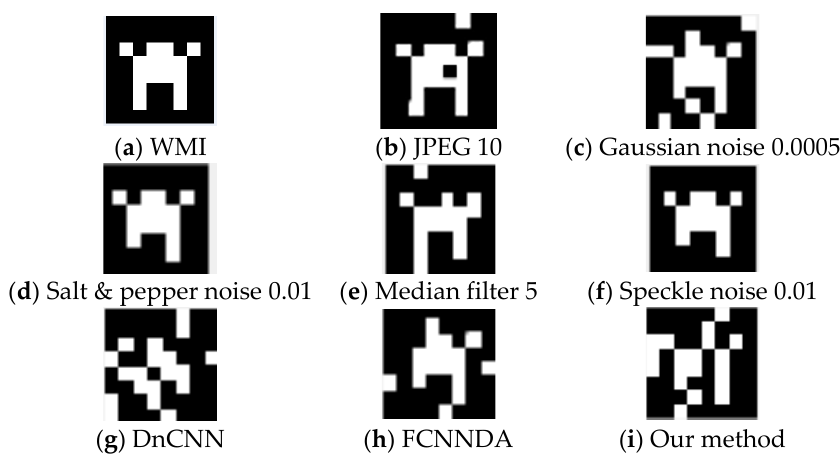
Figure 8. The image watermark extracted from the AWMI; the watermark size is 8 × 8.